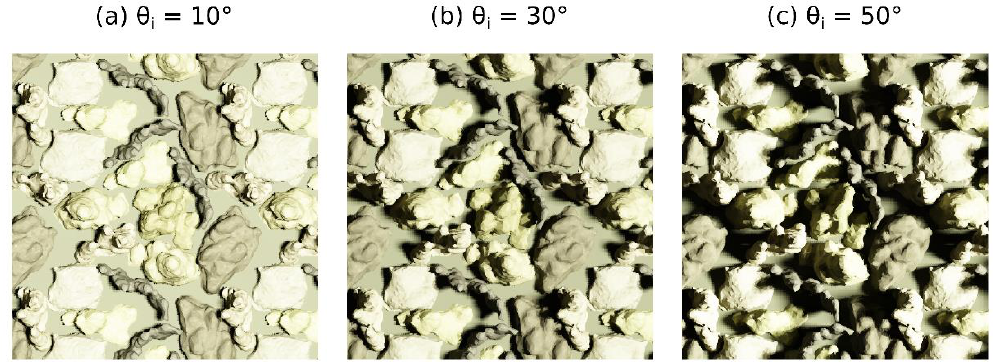
Figure 8. Examples from BRDF generation of canopy using reflectances of deep corals at 74% coral coverage (D74). Shown as nadir-view ( θ e = 0 ◦ ) orthogonal projected rendering above each canopy, corresponding to incident radiance from: ( a ) θ i = 10 ◦ ; ( b ) θ i = 30 ◦ and; ( c ) θ i = 50 ◦ , respectively, azimuth ϕ s = 0 ◦ . RGB images are created from hyperspectral data using the tristimulus functions and represent an area of 30 cm × 30 cm.